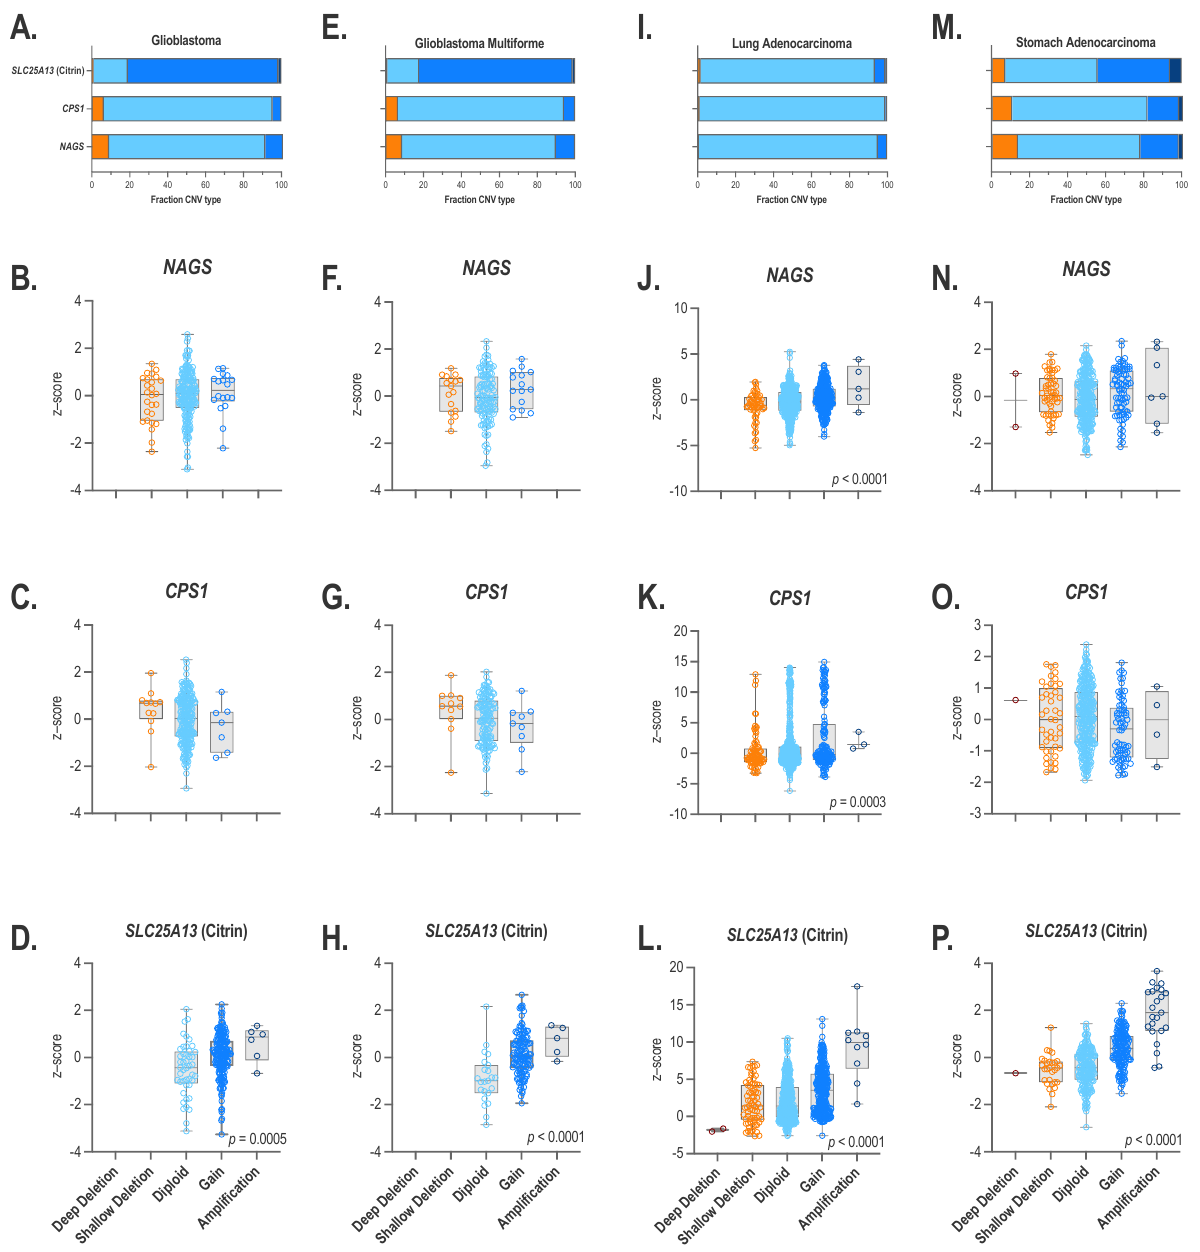
Figure 4. Copy number variation and NAGS , CPS1, and citrin mRNA expression. Fraction of glioblastoma ( A ), glioblastoma multiforme ( E ), lung adenocarcinoma ( I ) and stomach adenocarcinoma ( M ) samples with deep deletions, shallow deletions, two copies, gain and amplification of NAGS , CPS1, and citrin genes. Relationship between copy number and NAGS ( B , F , J , N ), CPS1 ( C , G , K , O ) and citrin ( D , H , L , P ) mRNA expression. Brown – deep deletion, orange – shallow deletion, light blue – diploid, medium blue – gain, dark blue – amplification of the genomic regions of interest. The CNV of NAGS and CPS1 were similar in stomach adenocarcinoma samples. The majority of the stomach adenocarcinoma samples, 64% and 71%, were diploid for NAGS and CPS1 genes, respectively; 20% and 16% of the stomach adenocarcinoma samples exhibited gains of NAGS and CPS1 , respectively; 13% and 10% of stomach adenocarcinoma samples exhibited shallow deletions of NAGS and CPS1 , respectively; and the remaining stomach adenocarcinoma samples had either deep deletions or amplifications of the two genes (Figure 4M). The majority of the stomach adenocarcinoma samples were either